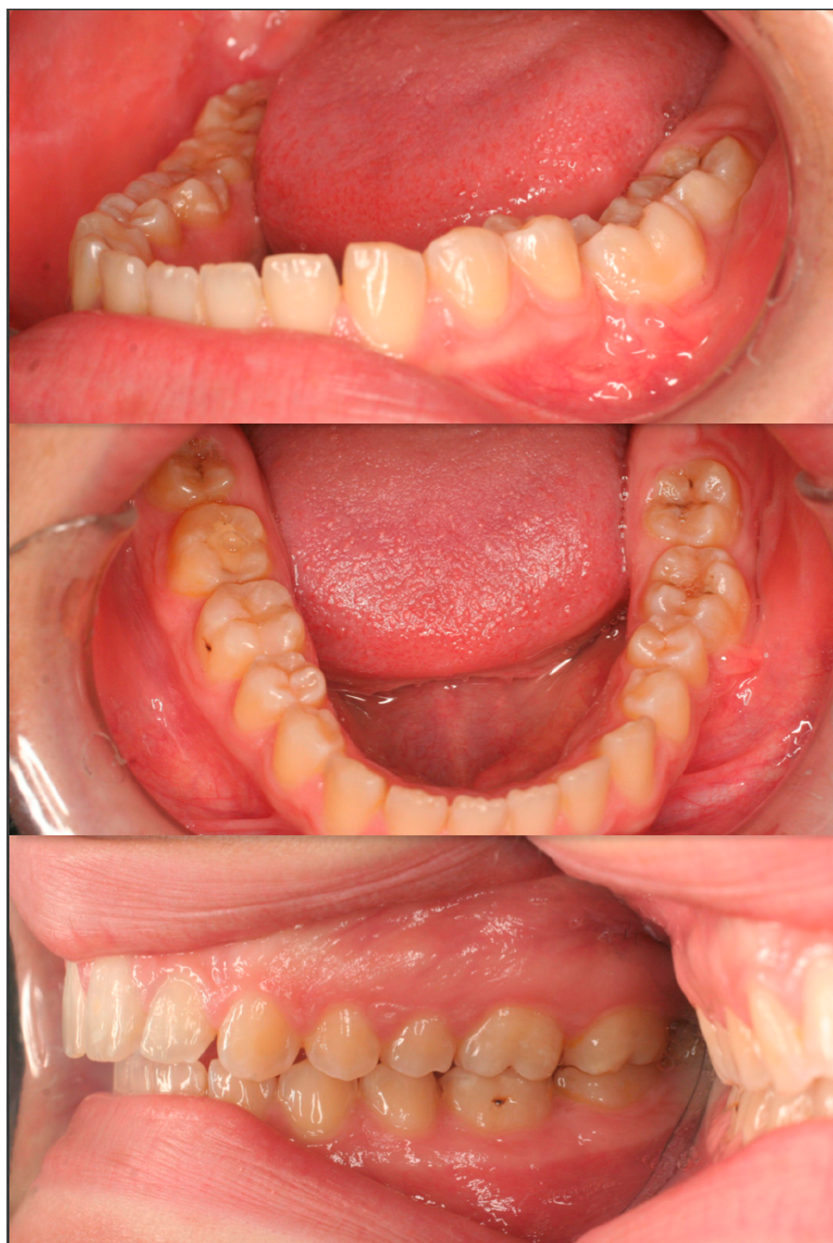
Figure 6. 14 months after debonding of the fixed orthodontic appliances. The first mandibular